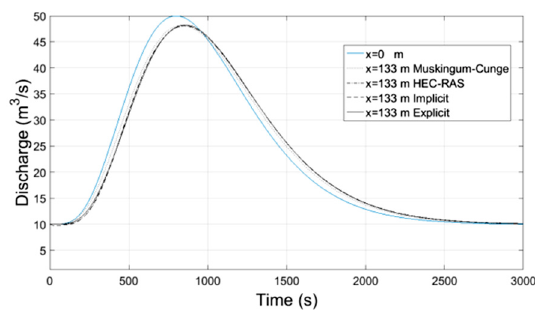
Figure 13. Discharge-Time at x = 133 m.